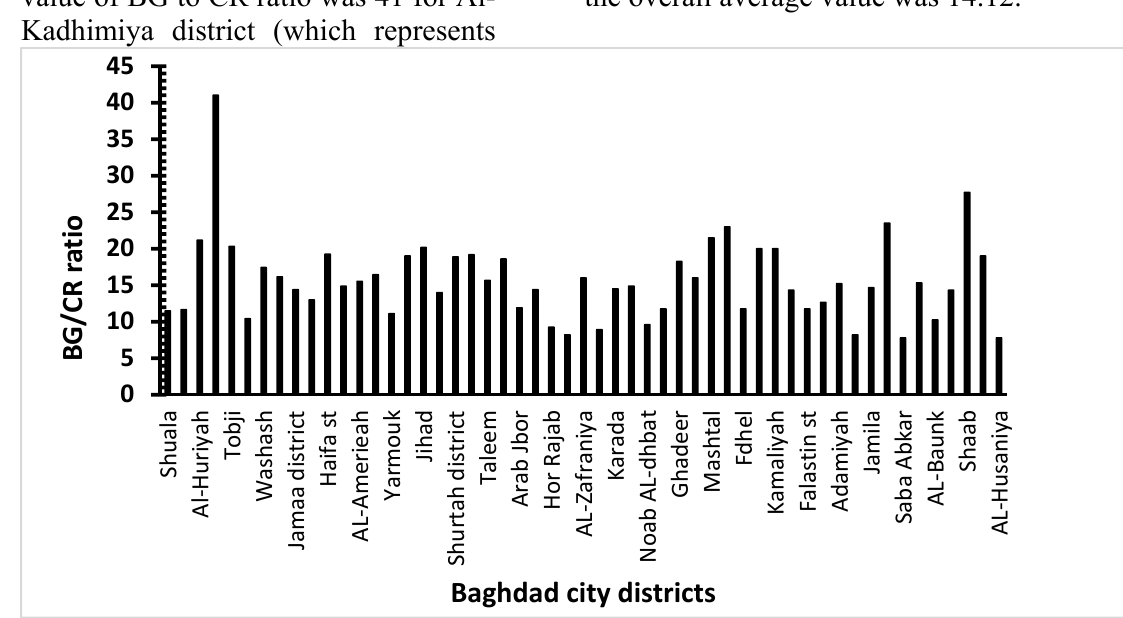
Fig. 2: The BG to CR dose rates ratio for Baghdad